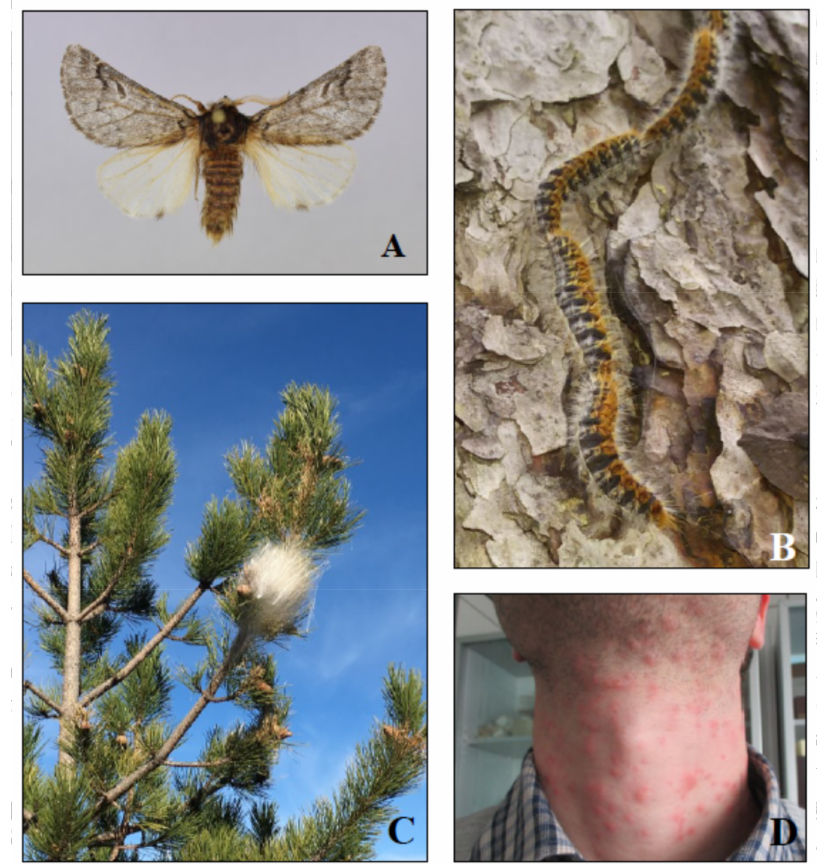
Figure 1. Thaumetopoea pityocampa : male (wingspan 30–40 mm) ( A ), mature larvae (about 40 mm) ( B ), winter nest (about 20 cm) ( C ) and urtication produced in humans ( D